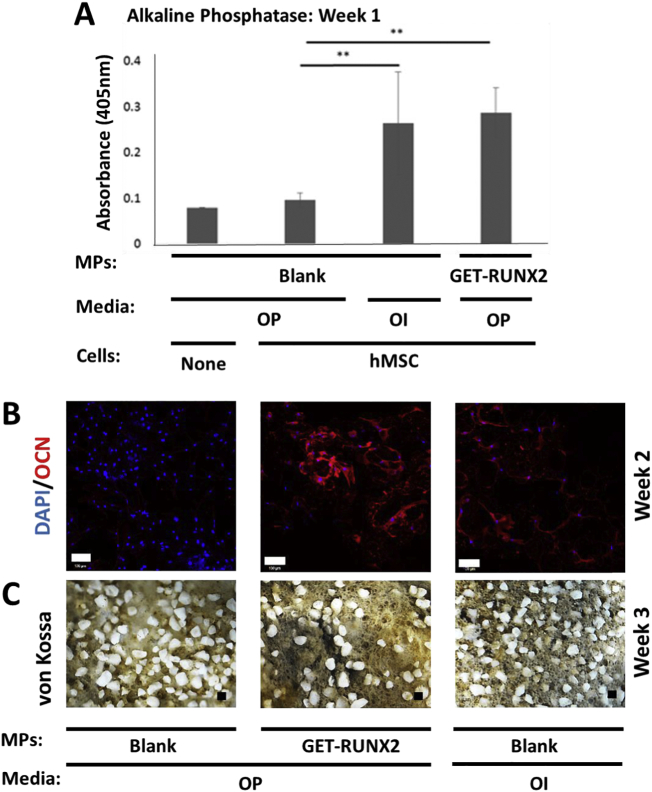
hMSC osteogenic differentiation on PLGA/PEG scaffolds. Differentiation markers for hMSCs seeded on scaffolds in osteo-permissive (OP) and osteo-inductive media (OI). (A) Alkaline phosphatase (ALP) quantification at week one comparing blank and GET-RUNX2 MPs, with OI conditions and without hMSCs as a control. (B) OSTEOCALCIN (OCN) immunostaining (red) with DAPI nuclear staining (blue) at week 2 (scale bar is 100 μm). (C) Von kossa-stained samples at week 3 (scale bar is 100 μm). Blank MPs represents cell seeded scaffold containing blank MPs cultured in osteo-permissive (OP) media. Loaded MPs represents cell-seeded scaffolds containing P21-RUNX2-8R-loaded MPs cultured in osteo-permissive (OP) media. OI media represents cell seeded scaffolds containing blank MPs cultured in osteoinductive media (OI). ** is P < .01.